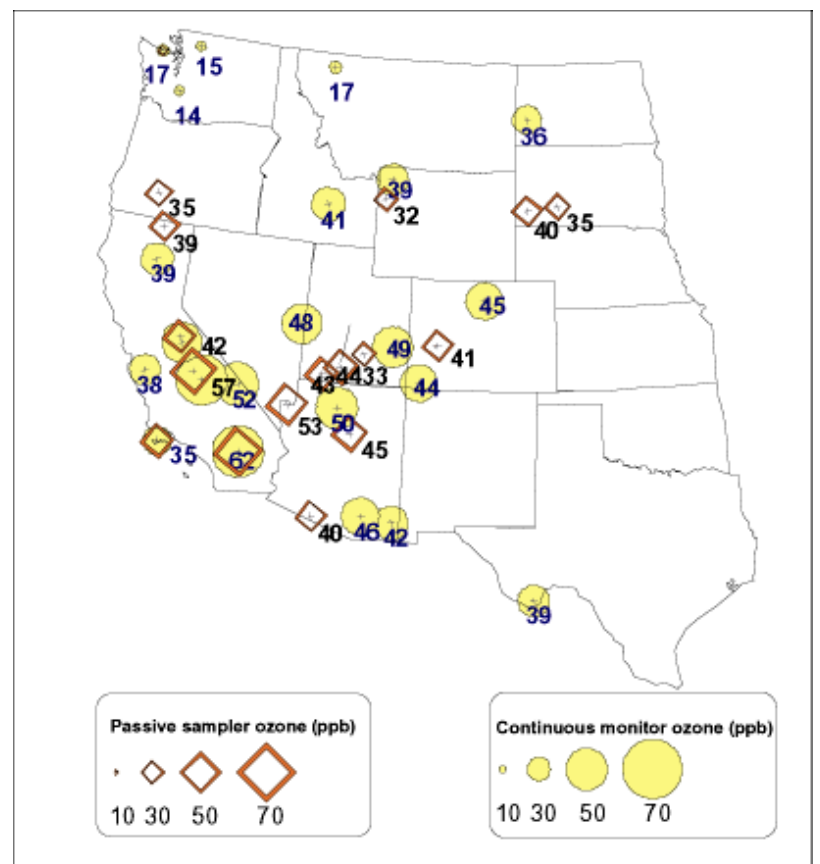
FIGURE 4. Average 1997 seasonal ozone concentrations based on NPS measurements at rural western U.S. park locations. The size of the symbols is proportional to the ozone concentration. Passive sampling sites are marked by diamonds, and continuous analyzer sites are marked by filled